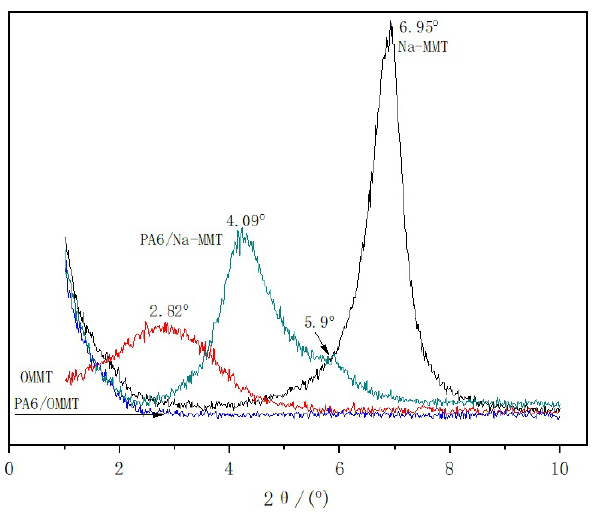
Figure 1: XRD spectra of MMTs and PA6/MMT